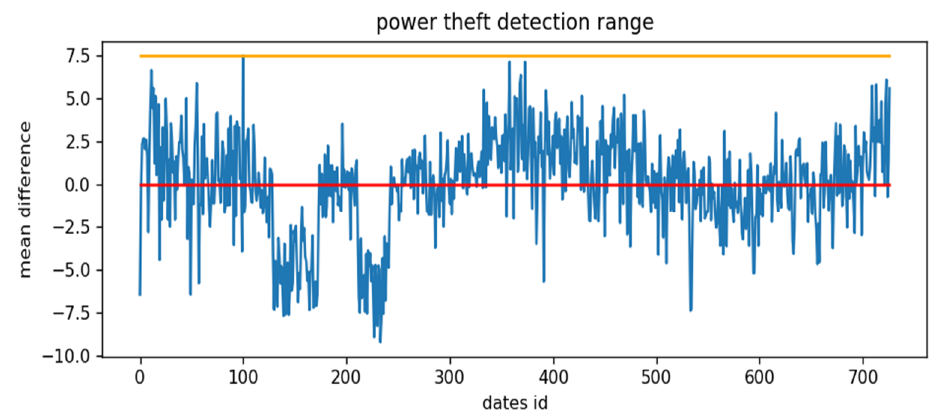
Figure 13. The optimal range of power theft (kW), no power theft detected.